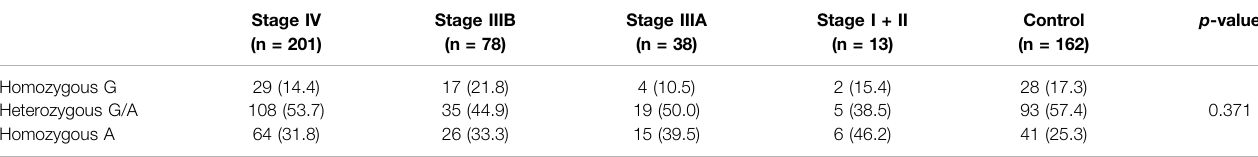
TABLE 6 | The comparison on the genotype distribution of COX-2 – 1195G/A gene among lung cancer patients with different disease stages and control participants.